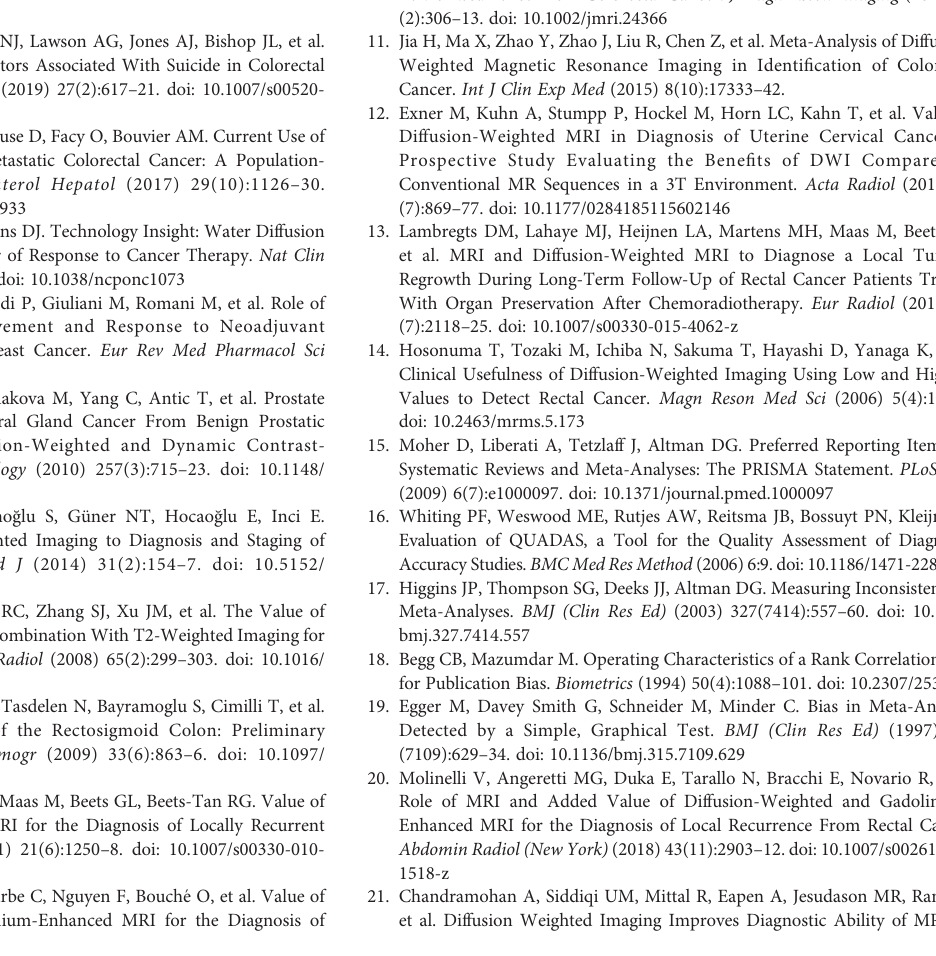
Supplementary Figure 1 | Risk of bias assessment of included studies. Supplementary Figure 2 | (A) Summary sensitivity analysis of the included studies published after 2015. (B) Summary speci fi city analysis of the included studies published after 2015. (C) Summary of positive likelihood ratio of the included studiespublished after 2015.d.Summary ofnegativelikelihoodratio ofthe included studies published after